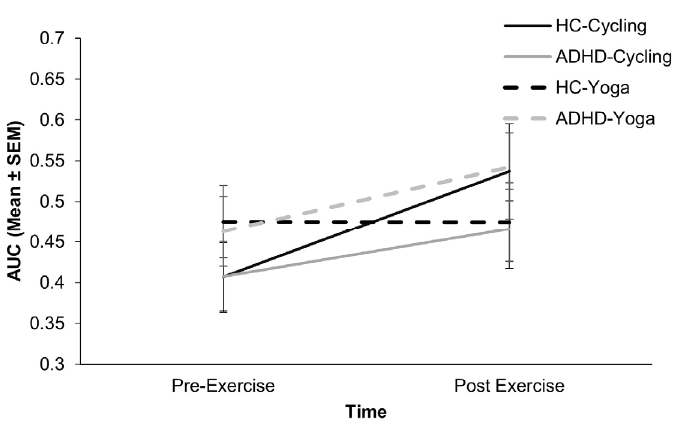
Figure 2. Temporal impulsivity, measured by the Area Under the Curve (AUC) in the Delay Discounting Task demonstrated that cycling exercise increased the AUC for healthy controls (HC-Cycling) and those with ADHD (ADHD-Cycling), indicative of reduced impulsivity. However, yoga only improved temporal impulsivity in the ADHD group (ADHD-Yoga) and not the control group (HC ‐ Yoga).